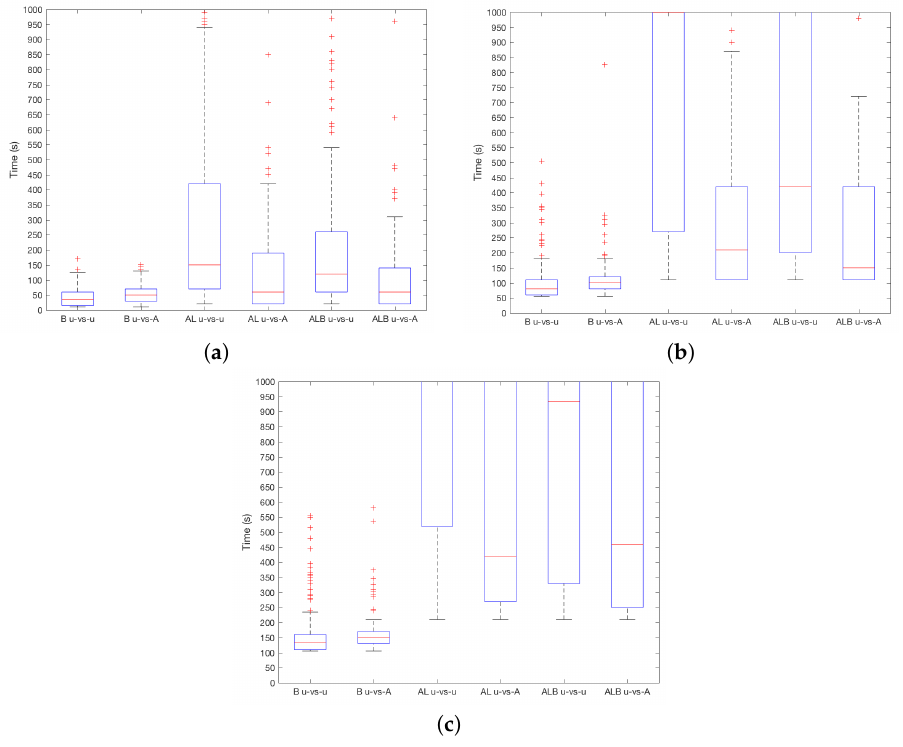
Figure 3. T SEC results for user-vs.-attacker and user-vs.-user settings. ( a ) ST = 1; ( b ) ST = 10; ( c ) ST =